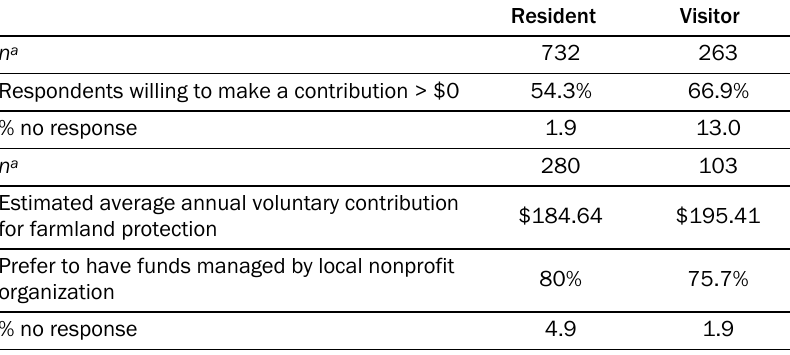
Table 9. Willingness to Pay for Farmland Protection and Preferred Fund Management (all currency in